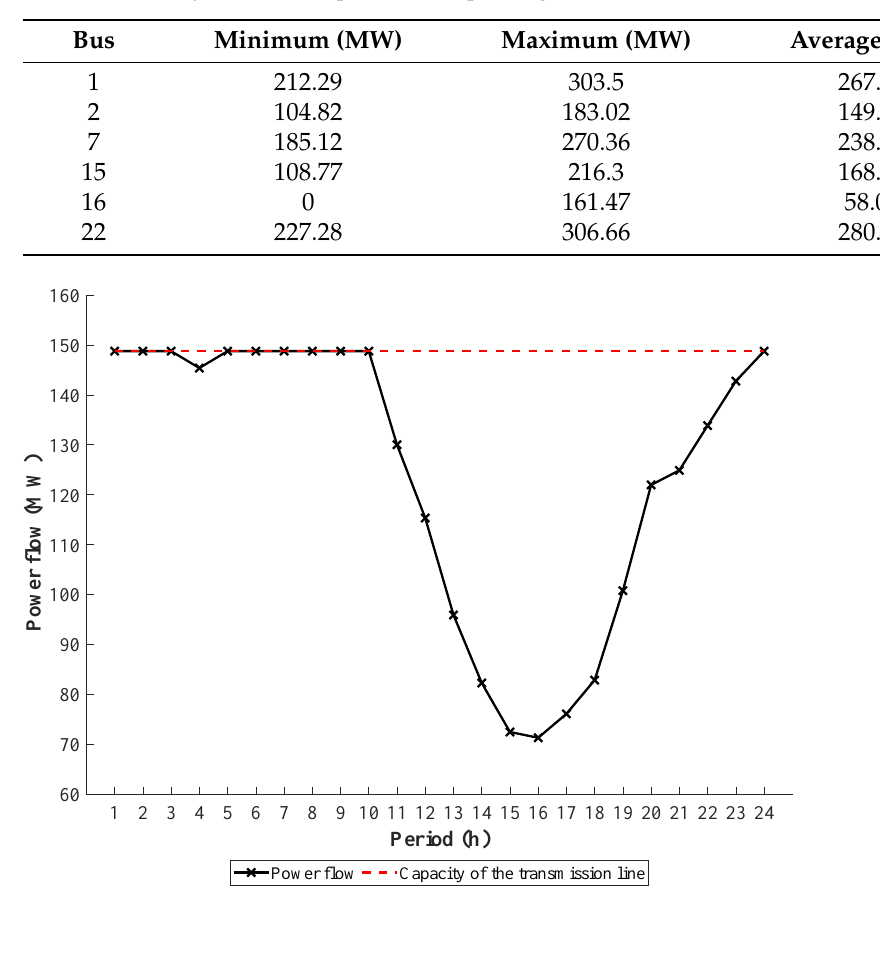
Figure 8. Power flow at transmission line 11 in Case